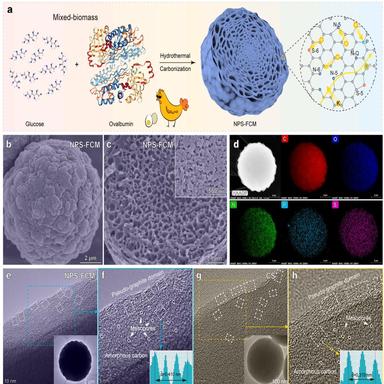
Synthesis illustration and micro-morphology/carbon lattice characteristics. a) Schematic illustration of the synthesis process of NPS-FCM. b) Scanning electron microscopy (SEM), c) cross-sectional view, and (d) HAADF-STEM image and corresponding EDS element mapping of NPS-FCM. HR-TEM images of (e–f) NPS-FCM and (g–h) CS materials.